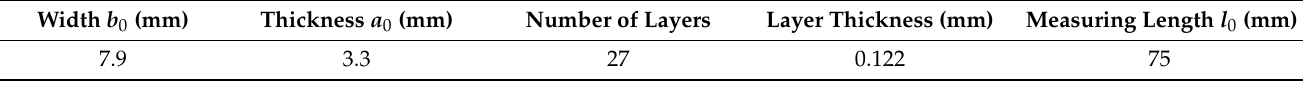
Table 3. Averaged dimensions of simulation model of tested samples with Composite Layup.